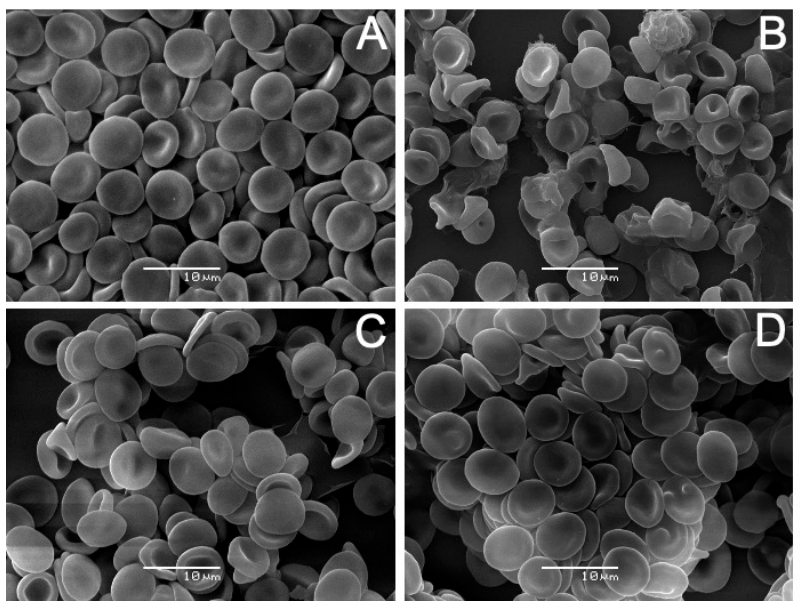
Figure 9. AVCRI104P4 protective effect on human erythrocytes. SEM images of ( A ) untreated erythrocytes; incubated with ( B ) 20 μ M A β (1-42); ( C ) 10 μ M AVCRI104P4 and 20 μ M A β (1-42); ( D ) 20 μ M AVCRI104P4 and 20 μ M A β (1-42).